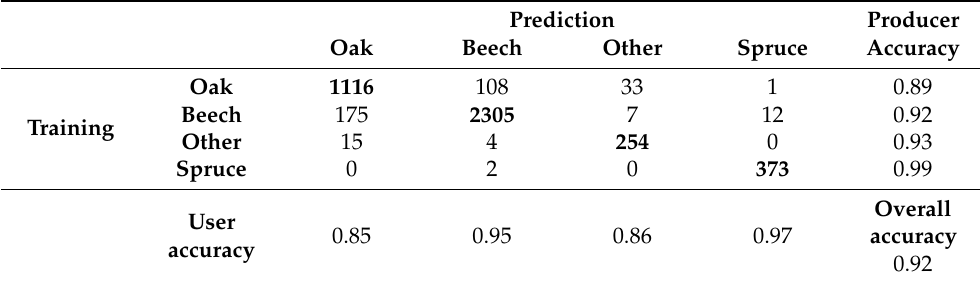
Table 5. Confusion matrix for the species class